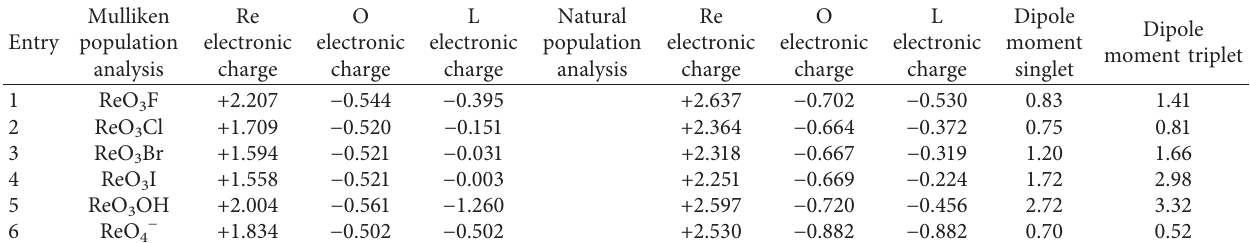
Table 1: Mulliken and natural population analysis as well as the dipole moments of rhenium oxo complexes. Entry